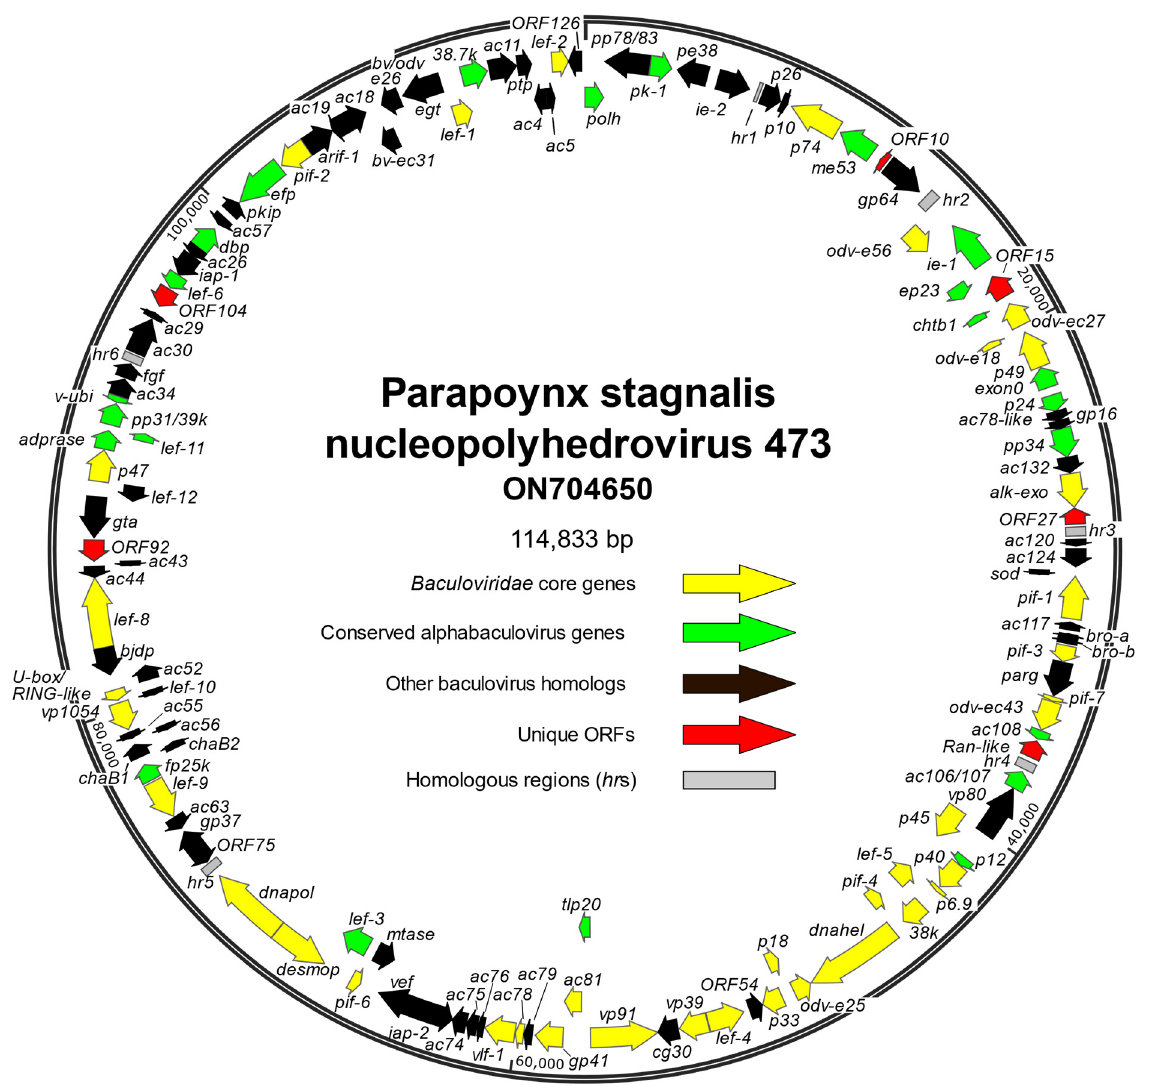
Figure 1. Physical map of the genome of Parapoynx stagnalis nucleopolyhedrovirus (PastNPV) isolate 473. The position and orientation of open reading frames (ORFs) are represented by arrows, which are color-coded to indicate ORFs corresponding to core genes of family Baculoviridae (yellow), ORFs that are conserved among viruses of genus Alphabaculovirus (green), ORFs with homologs in a subset of baculoviruses (black), or ORFs unique to PastNPV-473 (red). ORFs are designated by the names with which they are referenced in the literature, or by a number corresponding to their annotation in the PastNPV-473 genome. Gray boxes correspond to homologous regions ( hr s).